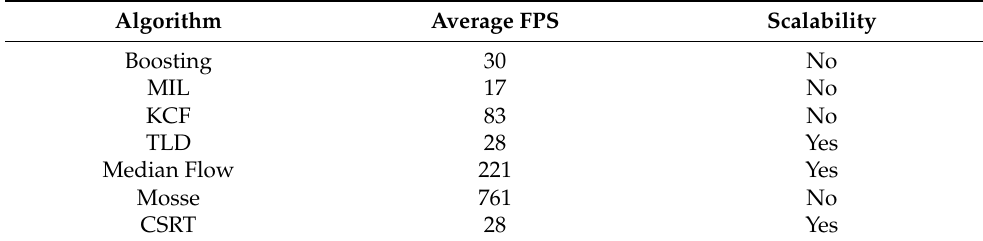
Table 3. Analysis table for tracking algorithms.